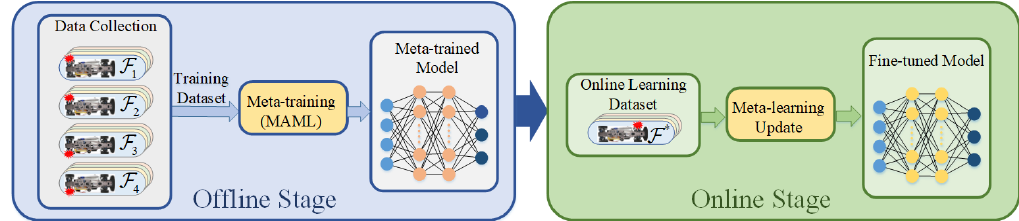
Figure 4. Framework of the meta-DDPG-based